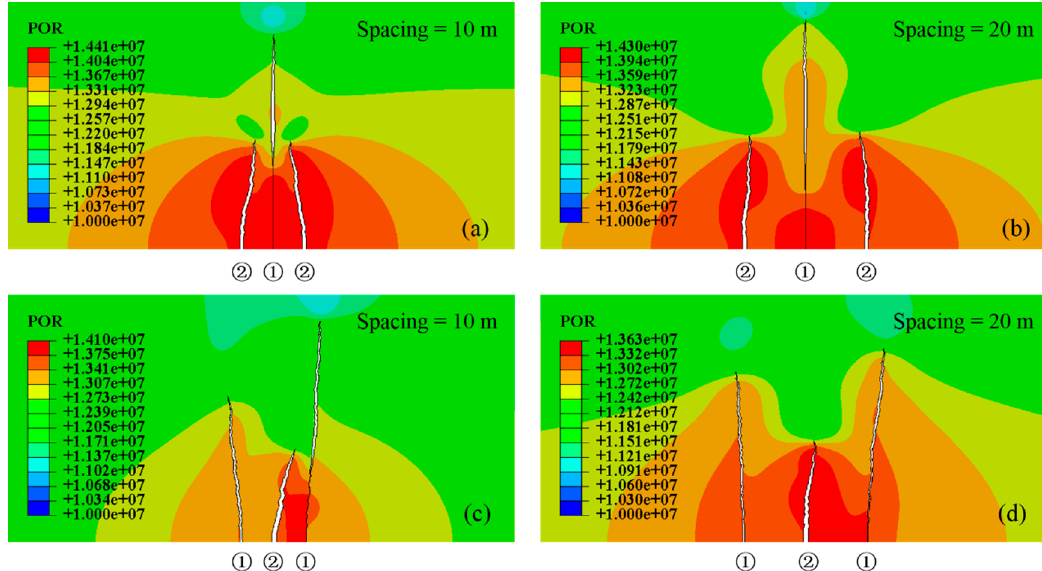
Figure 13. Fracture geometries of two-step and modified two-step fracturing with different closely-spacing (POR is the pore pressure: Pa): ( a ) Fracture geometries of two-step fracturing with spacing = 10 m; ( b ) Fracture geometries of two-step fracturing with spacing = 20 m; ( c ) Fracture geometries of modified two-step fracturing with spacing = 10 m; ( d ) Fracture geometries of modified two-step fracturing with spacing = 20 m.